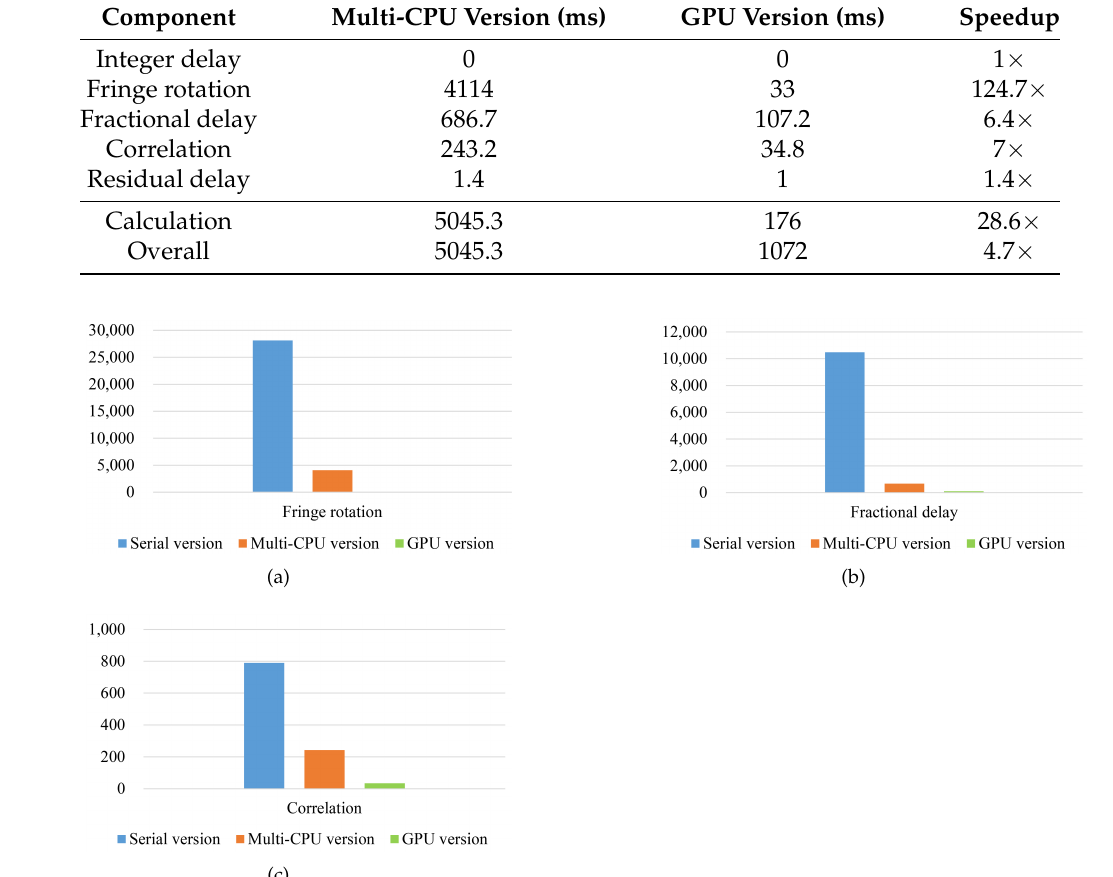
Figure 10. Execution time (ms) of each part in VLBI. ( a ) Fringe rotation. ( b ) Fractional delay. ( c ) Correlation.